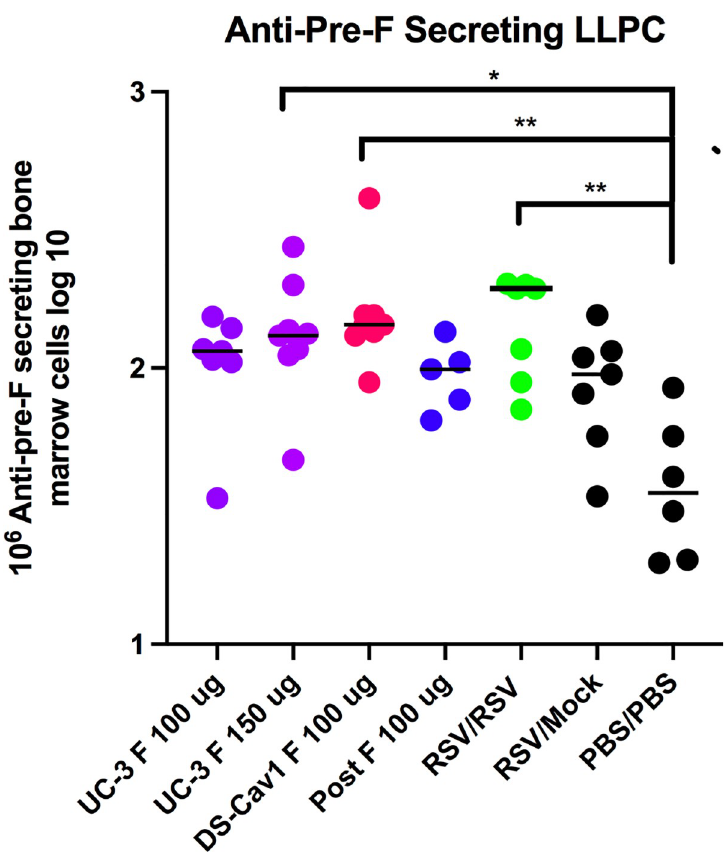
Fig 3. Bone marrow associated long-lived plasma cells (LLPC) secreting anti-pre-F IgG. At day 318, bone marrows of dams were acquired and the numbers of cells secreting anti-pre-F IgG were measured as described in Methods. Results from bone marrows of individual animals are shown as log 10 of the numbers of positive cells in 10 6 cells. Immunogen in dams is shown on the x axis. Solid line indicates mean titers in each data set. Significance of differences from unimmunized animals was determined by ANOVA followed by post-hoc Sıˆda´k multiple comparison test � p < 0.05; �� p < 0.01.